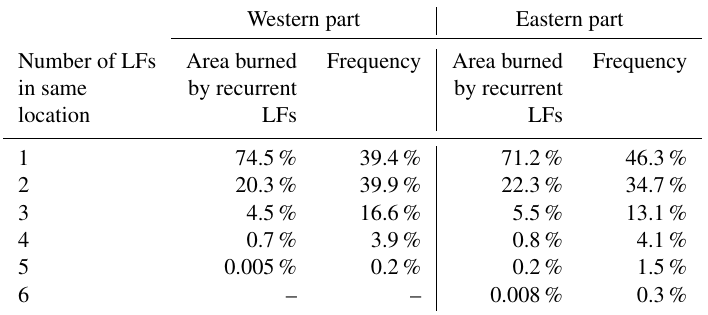
Table 2. Percentages of burned area (relative to the total burned area) affected by recurrent LFs and percentages of recurrence relative to the LF frequency (when number = 1, LF is considered non-recurring). Western part Eastern part Number of LFs Area burned Frequency Area burned by recurrent